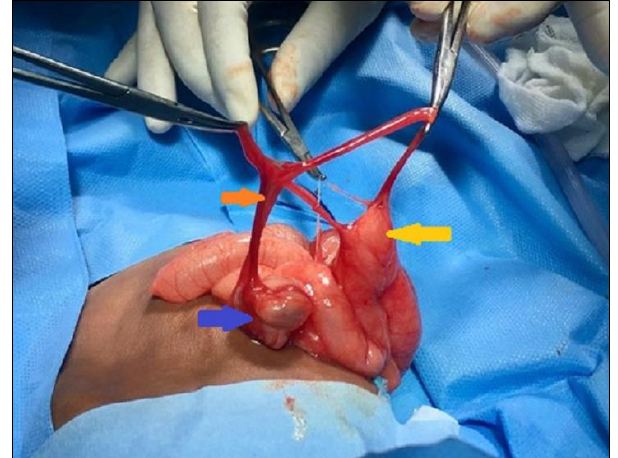
Figure 1: congenital adhesion bands. Ileum (yellow arrow), cecum (blue arrow), Ileo-ileal and ileo-colic bands (orange